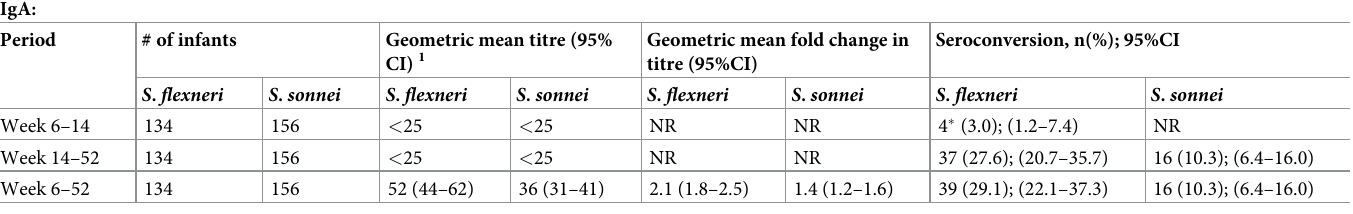
Table 4. Serum IgA anti-S. flexneri 2a or S. sonnei LPS response.